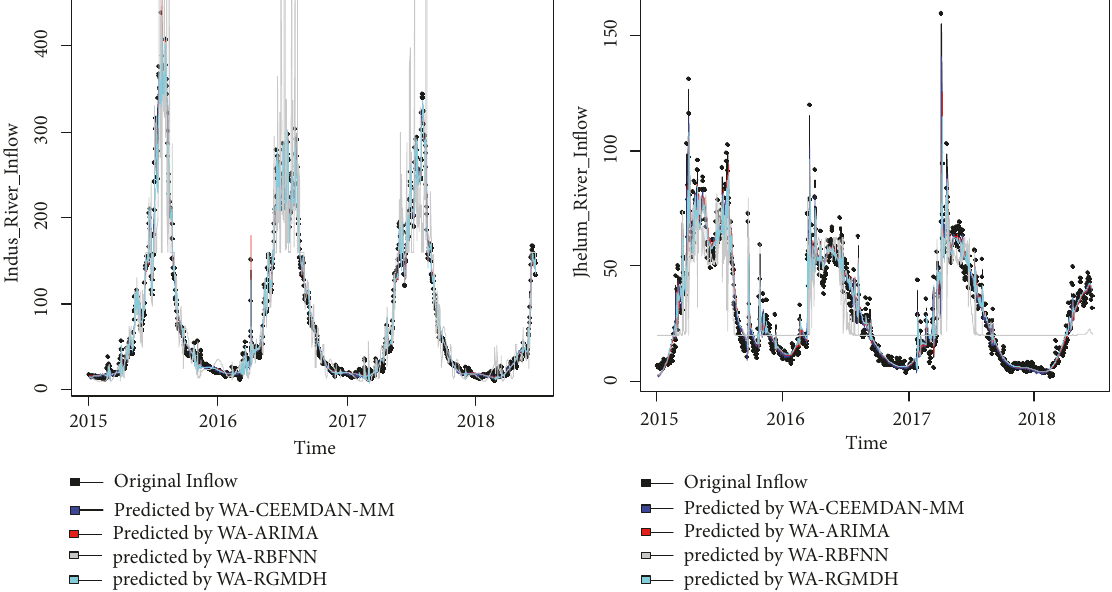
Figure 9: Prediction results of Indus and Jhelum river inflow using proposed WA-CEEMDAN-MMwith comparison to WA based denoised predicted